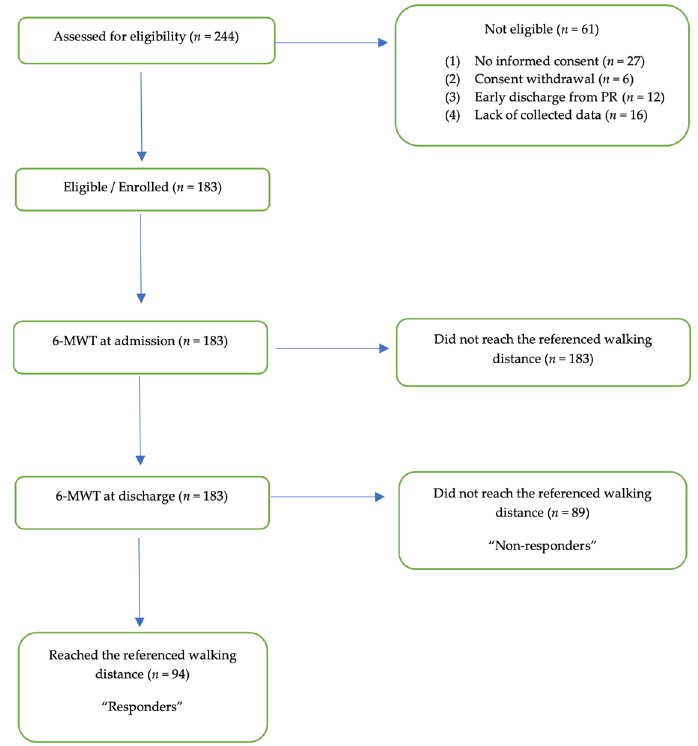
Figure 1. Study design.